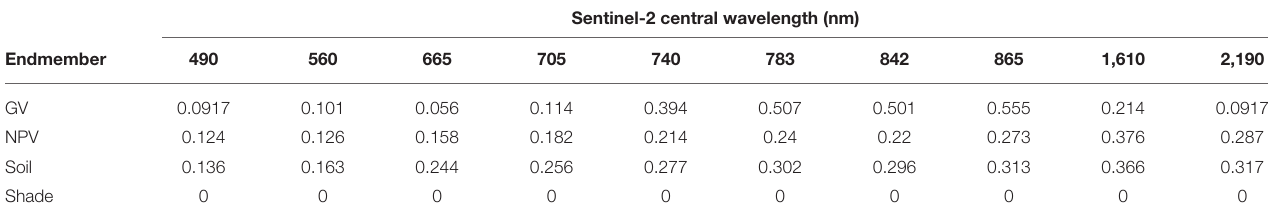
TABLE 2 | Sentinel-2 top of atmosphere reflectance values for the four endmembers used in this study, green vegetation (GV), non-photosynthetic vegetation (NPV), soil, and